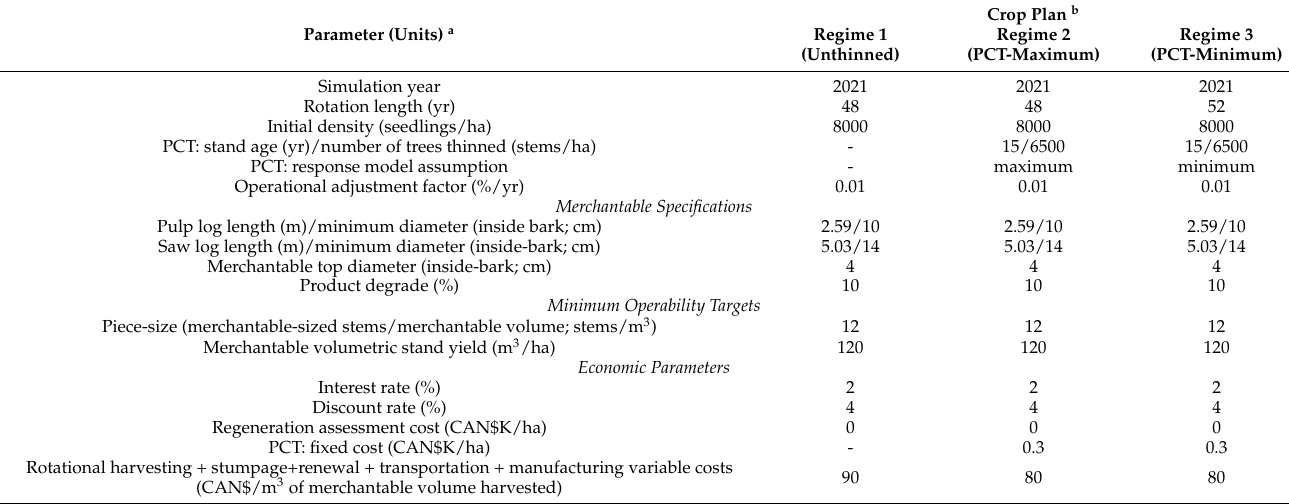
Table 3. Summarization of the input parameters deployed in the CP DSS demonstration of the Operability Optimizer for dense natural-origin jack pine stands, as extracted from Figure